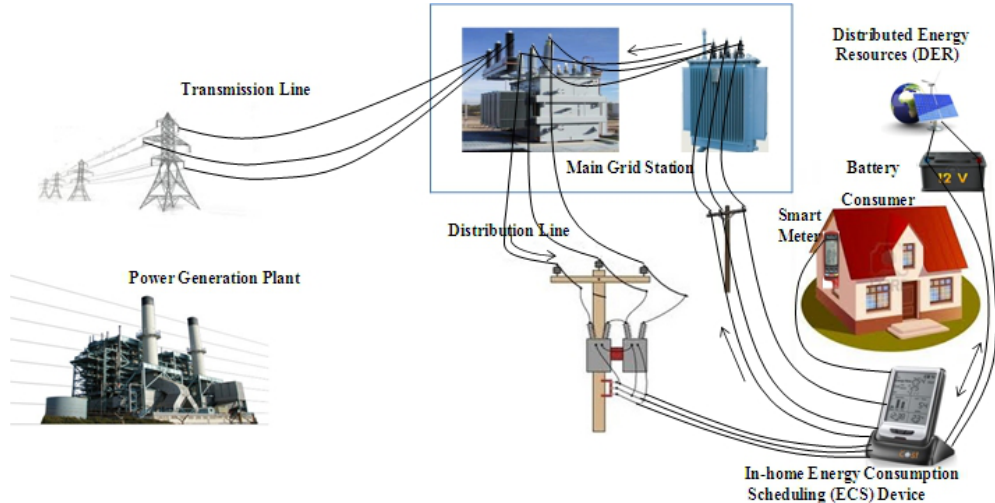
Figure 1. General layout of the smart grid‘s architecture.